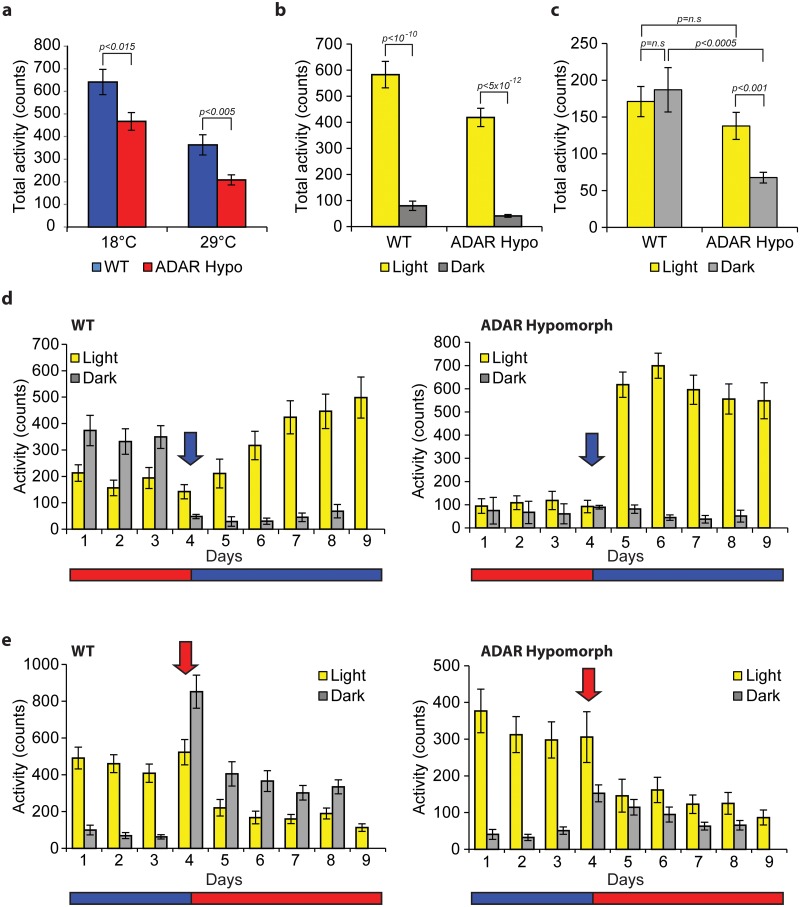
ADAR hypomorph flies display temperature dependent behavioral abnormalities.(A) ADAR hypomorph flies (red) are less active than control flies (blue) both at 18°C and 29°C. Total activity per day obtained by adding the average activity during the light and dark periods (8 days). N = 32 and 29 for hypomorph flies at 18°C and 29°C respectively and N = 27 for control flies at both temperatures. Statistical significance was assessed by Student-t test. Error bars represents SEM. (B) Although less active than their controls, at 18°C, the pattern of day-night activity of ADAR hypomorph and control flies is similar, with higher activity during the day. We calculated and ploted the average activity during the light (9 days) or dark periods (8 nights). Statistical significance was assessed by Student-t test. Error bars represents SEM. (C) At 29°C, control flies increase their night activity whereas the ADAR hypomorph flies remaine active mostly during the day. Statistical significance was assessed by Student-t test. Error bars represents SEM. (D) Behavioral activity assay for control (left) and ADAR hypomorph flies (right) that were exposed to 12:12h light:dark (L:D) cycles at 29°C for 4 days and then transferred to 18°C (L:D cycles) for 5 days. N = 29 for control and N = 32 for Adar hypomorph flies. An arrow marks the transition time point. Error bars represent SEM. (E) same as in (D), with the opposite temperature transfer, from 18 to 29°C. N = 30 for control and N = 31 for ADAR hypomorph flies. An arrow marks the transition time point.